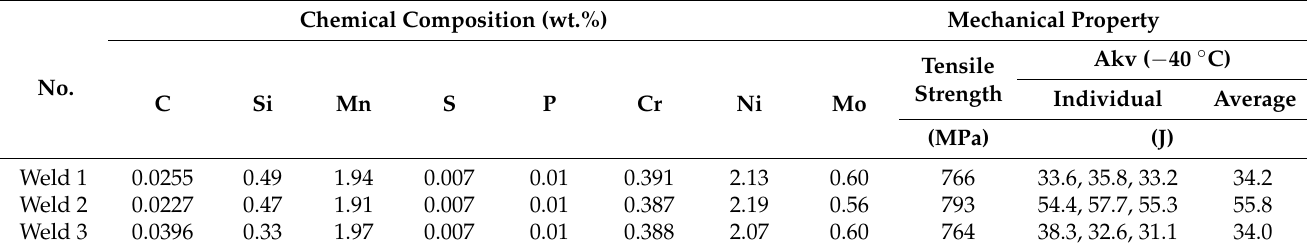
Table 3. Main chemical composition of deposited metal and mechanical properties